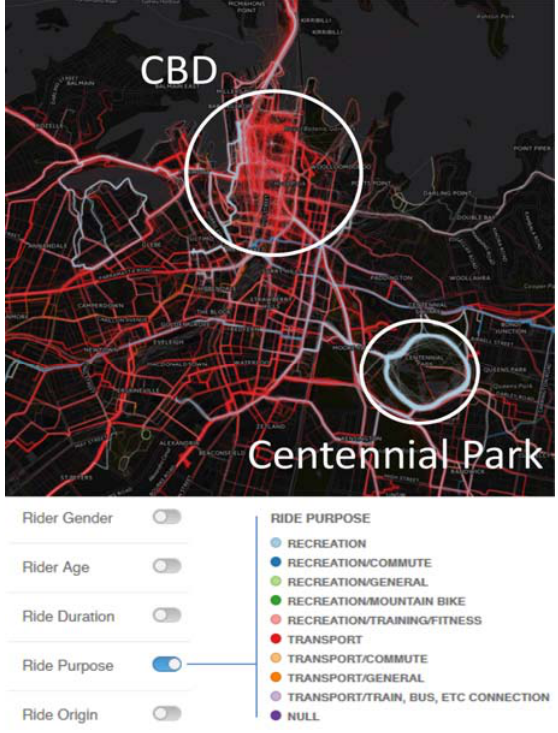
Figure 3. Sydney Area Rider Routes by Ride